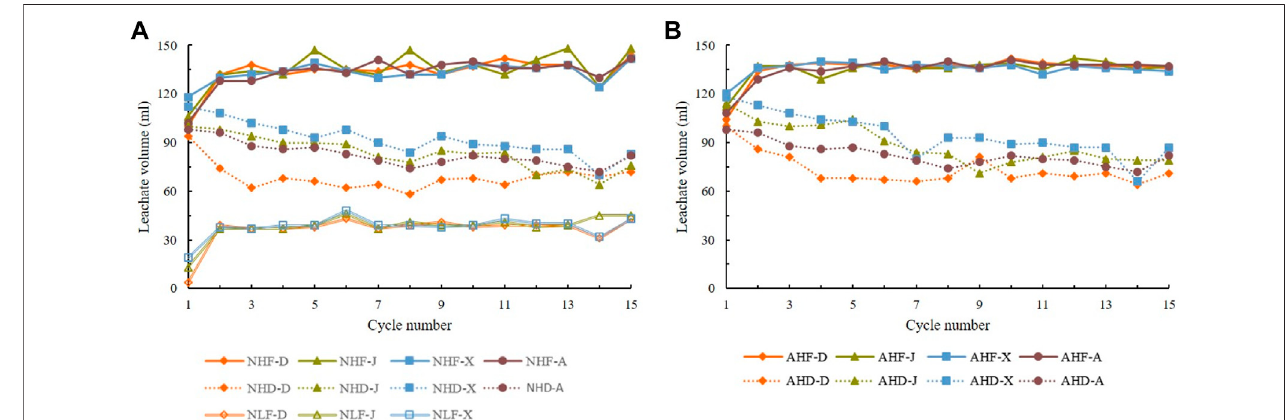
FIGURE 4 | Change of leachate volume over 15 cycles under (A) natural rain treatments and (B) acid rain treatments. Codes of treatments are N — natural rain and A — acid rain; H — high intensity and L — low intensity, D — drying temperature and F — freezing temperature; D sample from Datang badlands, China; J sample from Jiangtian badlands, China; X sample from Xiahui badlands, China; A sample from Araguás badlands, Spain.